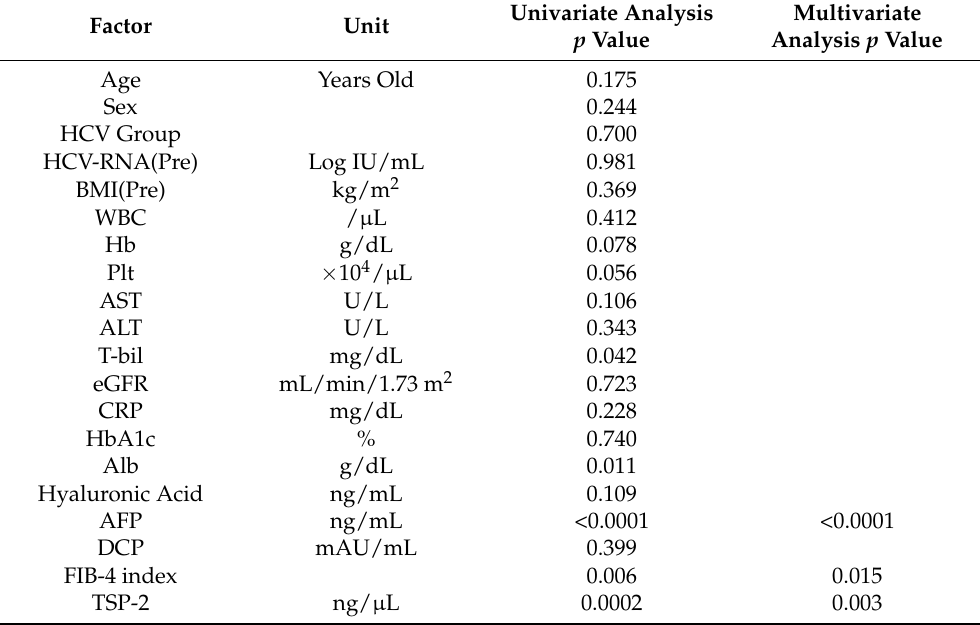
Univariate Analysis Multivariate p Value Analysis p Value